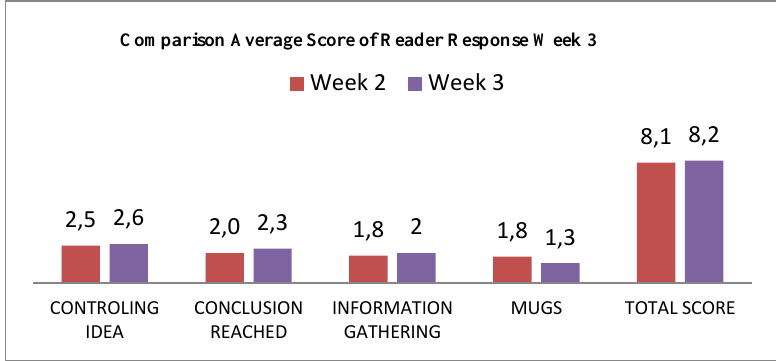
Chart3: Average score of reader response week 2 and week